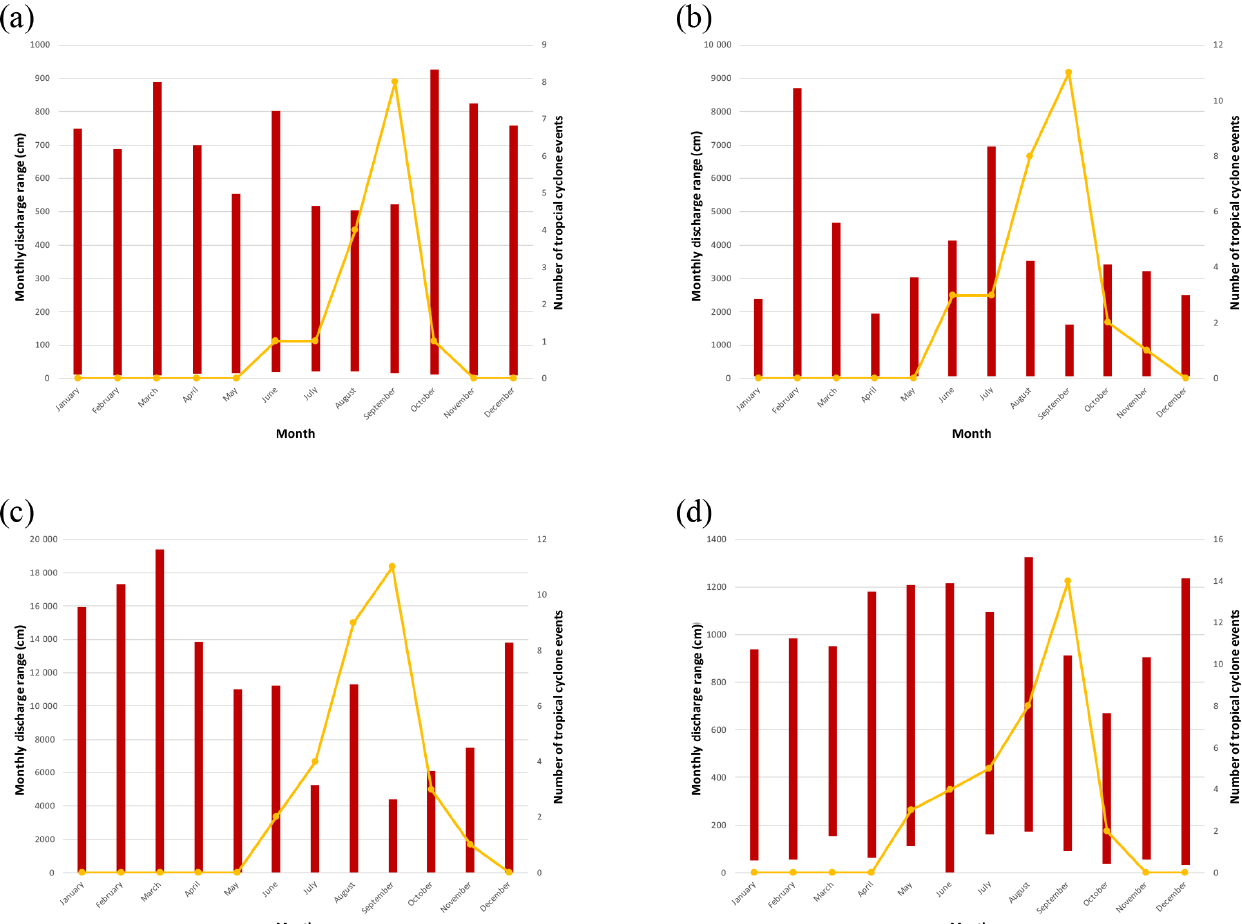
Figure 3. Comparison of monthly discharge maximum–minimum range (red bars) with the number of tropical cyclones occurring each month (yellow line) from 1998 to 2014 in the Neches (a) , Pearl (b) , Mobile (c) , and Roanoke (d)